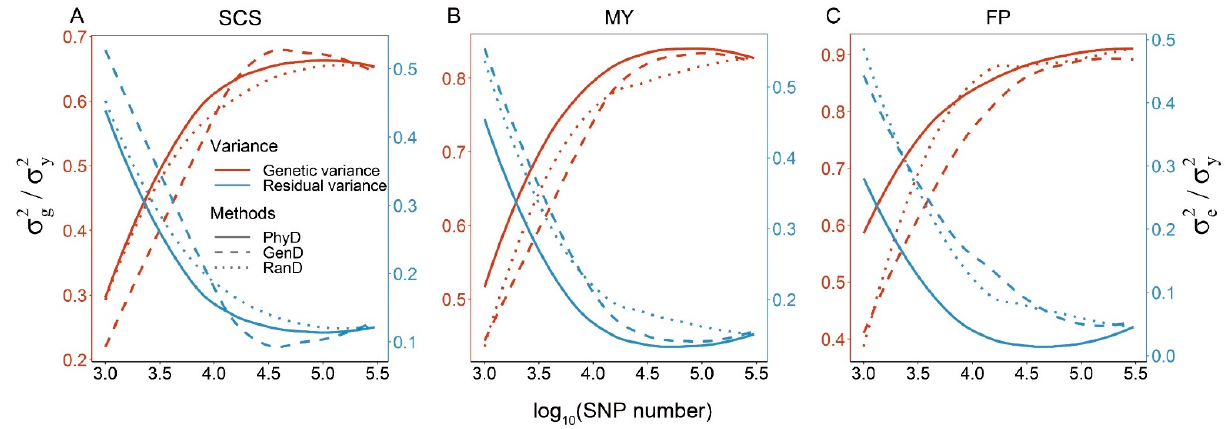
Figure 4. Smoothed conditional means of variance component estimates against SNP numbers for three dairy cattle traits. To facilitate representation, all variance component estimates were scaled with phenotypic variances, i.e., the genetic variance estimates and residual variance estimates were divided by the phenotypic variances, respectively. The smoothed conditional means of variance component estimates of panels with different SNP numbers constructed by PhyD, GenD or RanD for SCS, MY and FP are shown in ( A – C ) respectively.